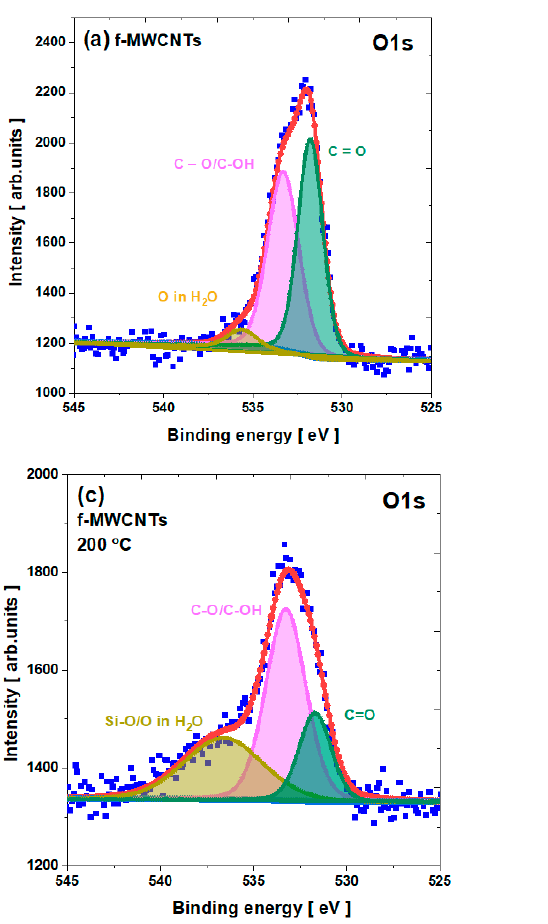
11 of 23 Figure 6. The N1 s core level line for f-MWCNTs: ( a ) pristine; ( b ) calcined at 100 °C; ( c ) calcined at 200 °C; and ( d ) calcined at 300 °C. The O1 s line is complex for all the nanotubes studied and can be attributed to three species (see Figure 7) (see Table S3 in Supplementary Materials). The complexity of the O1 s line can be derived from various components related to C=O (BE ≈ 531.6 eV), C-O/C- OH (BE ≈ 533.2 eV), and the peak at about 536 eV. The first peak dominates pristine nano- tubes, while the second is dominant for calcined nanotubes. Moreover, the last peak for